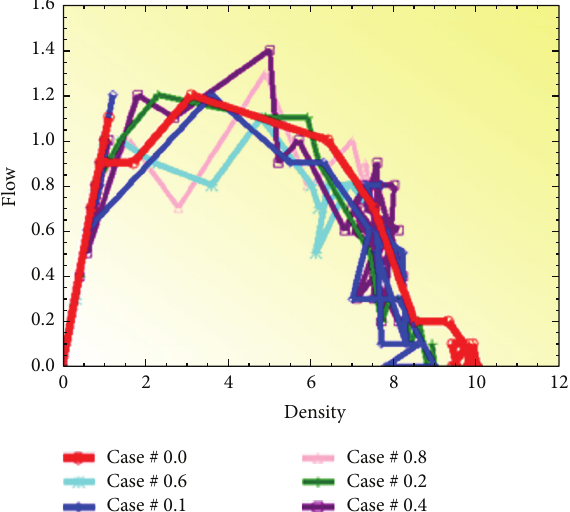
Figure 9: Density diagram in a blocked corridor.